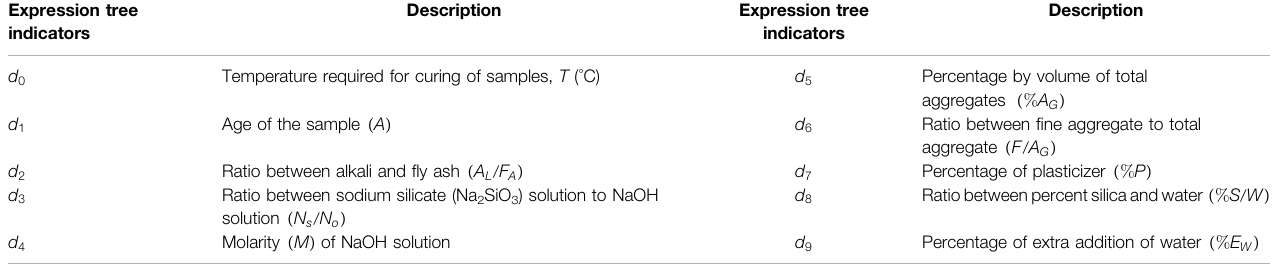
TABLE 5 | Description of indicators used in expression tree of the GEP model. Expression tree indicators